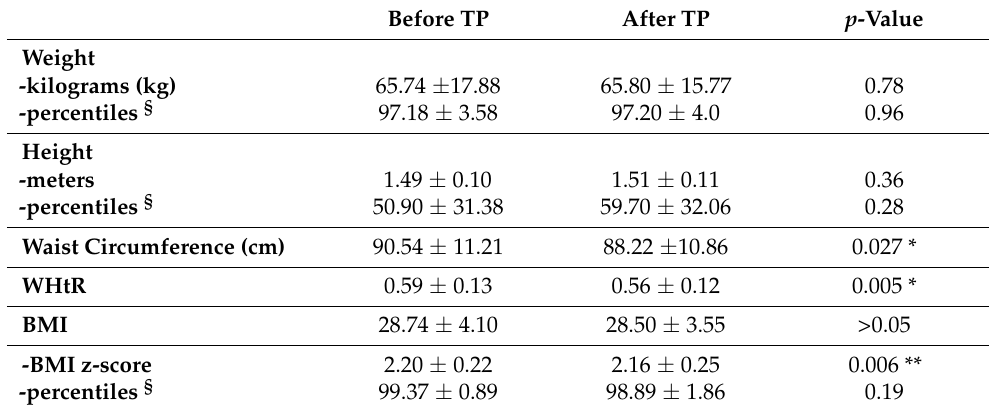
Table 2. Anthropometric data of the sample. Before TP After TP p -Value